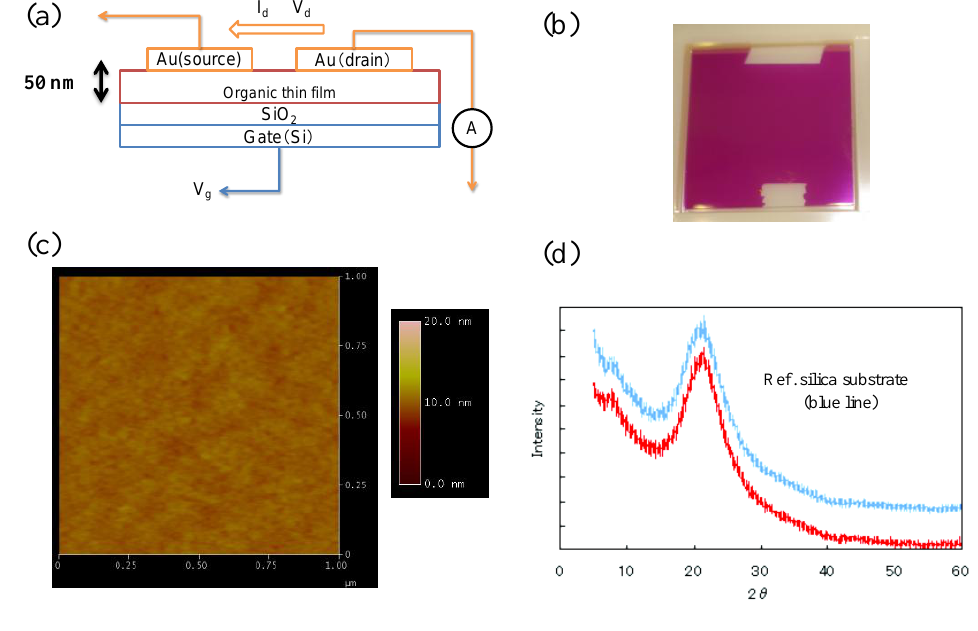
Figure 23. ( a ) Schematic illustration of a top-contact OFET device. ( b ) Photograph of the P -5 thin film. ( c ) AFM image of a P -5 thin film on a quartz substrate. ( d ) XRD patterns 66 66 for the P -5 thin film on a silicon substrate (red) and on a bare substrate 66